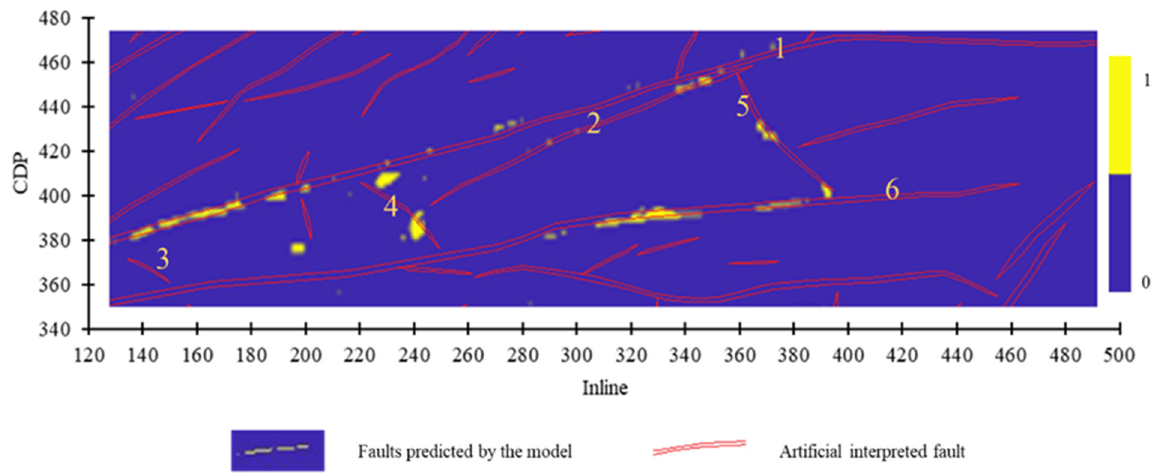
Figure 13. Result of Faults 1–6 predicted by Model 3.